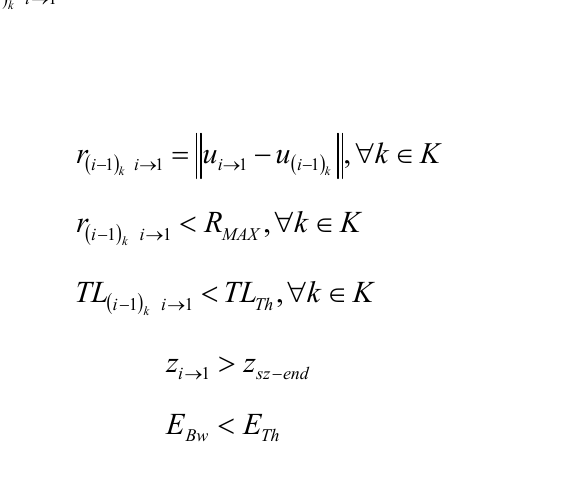
Figure 4. Scenario in the 3D UWSN with a shadow zone (Case